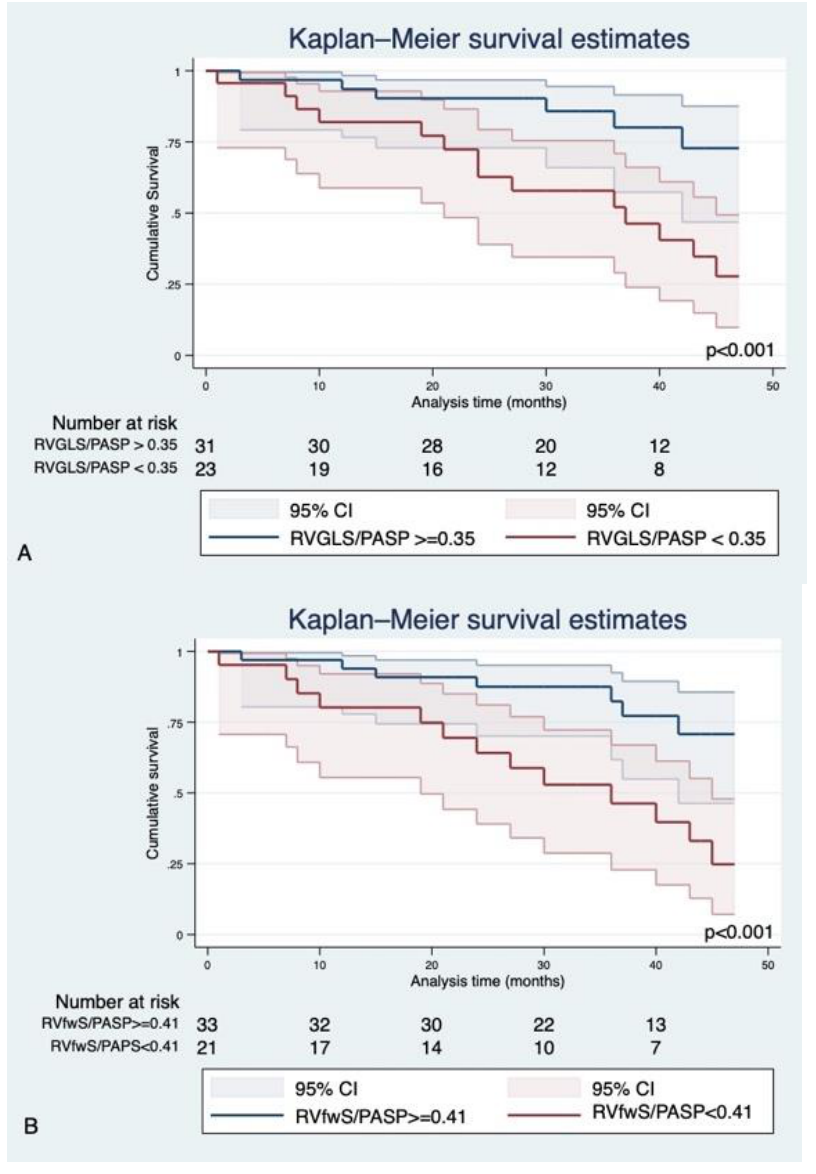
Figure 4. Kaplan–Meier survival analysis according to cut-offs identified for prediction of CRT response for variables RVGLS/PASP ( A ) and RVfwS/PASP ( B ). Table 3. Univariate and multivariate Cox regression survival analyses.